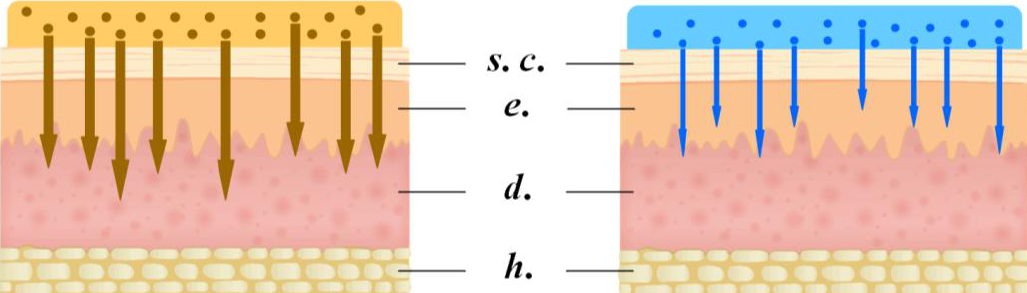
Scheme 2. Left panel schematically illustrates release of a hydrophobic low-molar-mass compound from a lipophilic depot. Right panel demonstrates the situation when the hydrophilic compound is released from the hydrophilic reservoir. s. c. stratum corneum = thickness 10–15 µ m e . epidermis = 150 µ m d . dermis = 1–2 mm h . hypodermis/subcutis.